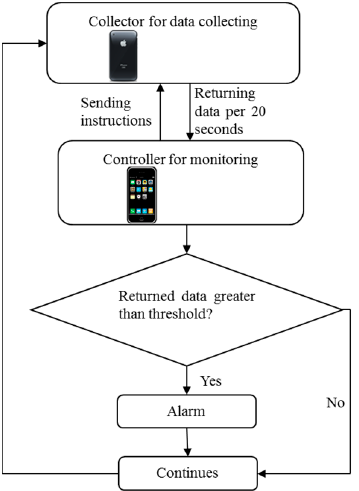
Figure 2. Flowchart of the monitoring and alarm systems.